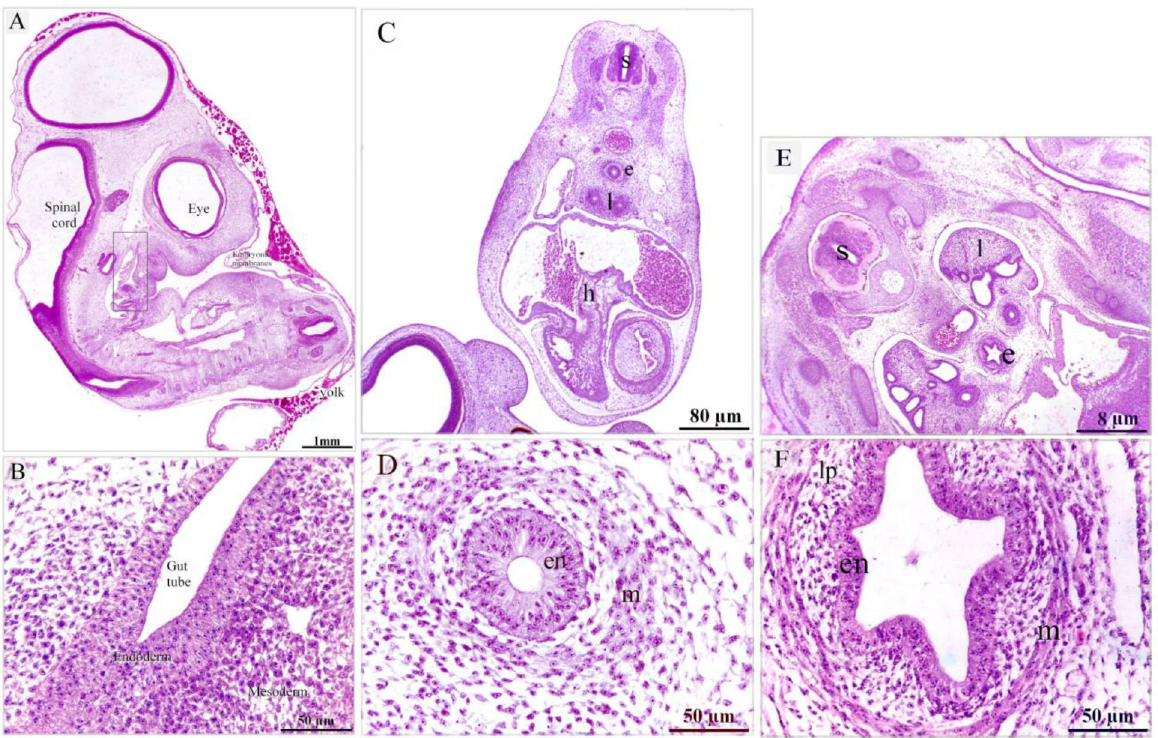
Figure 1. Formation of the gut tube and development of the circular muscular wall. Paraffin sections of day 4 ( A , B ), 5 ( C , D ), day 6 ( E – G ) of quail embryo stained with hematoxylin and Eosin (H&E). ( A ) The whole embryo developed the gut tube (the squared area). ( B ) Higher magnification of the gut tube show endoderm covered by mesoderm. ( C ) Spinal cord (s), primitive esophagus (e), lung buds (lu), heart (h). ( D ) Higher magnification of the initial part of the foregut; the primitive esophagus. Note Mesenchymal condensation (m) which represents muscular wall development, endoderm (en) of pseudostratified type of the epithelium. ( E ) Spinal cord (s), lung (l), esophagus (e). ( F ) Esophagus developed the circular muscular layer (m) of smooth muscle cells. The mucosa was folded and consisted of endodermal cells (en) of pseudostratified epithelium and lamina propria